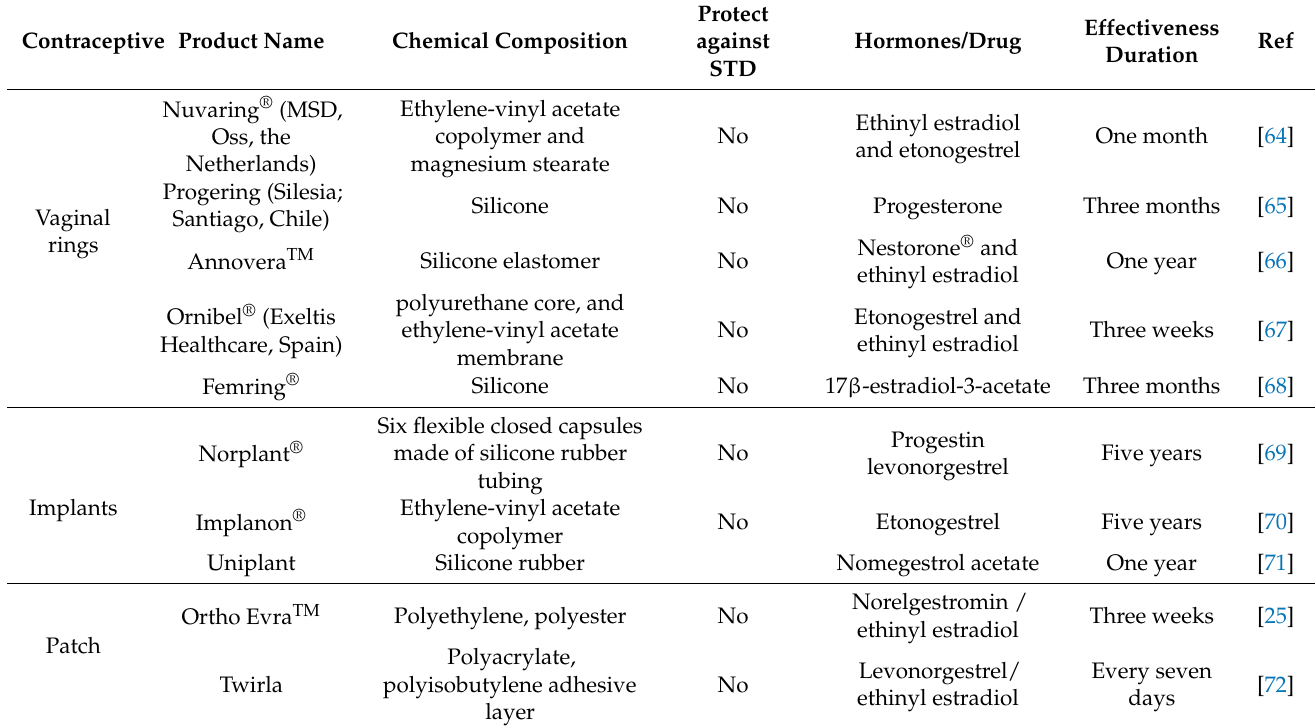
Table 1. Characteristics of commercially available vaginal